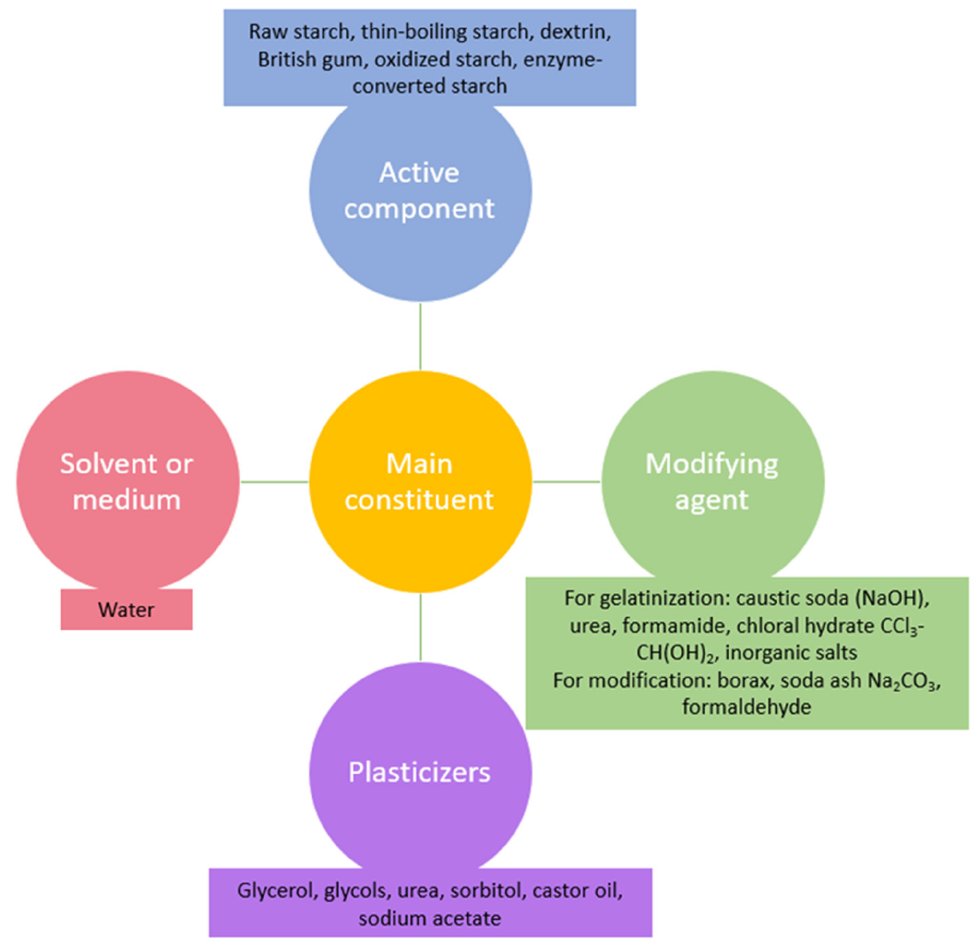
Figure 3. Four main constituents of starch-based adhesives [1,17,37].